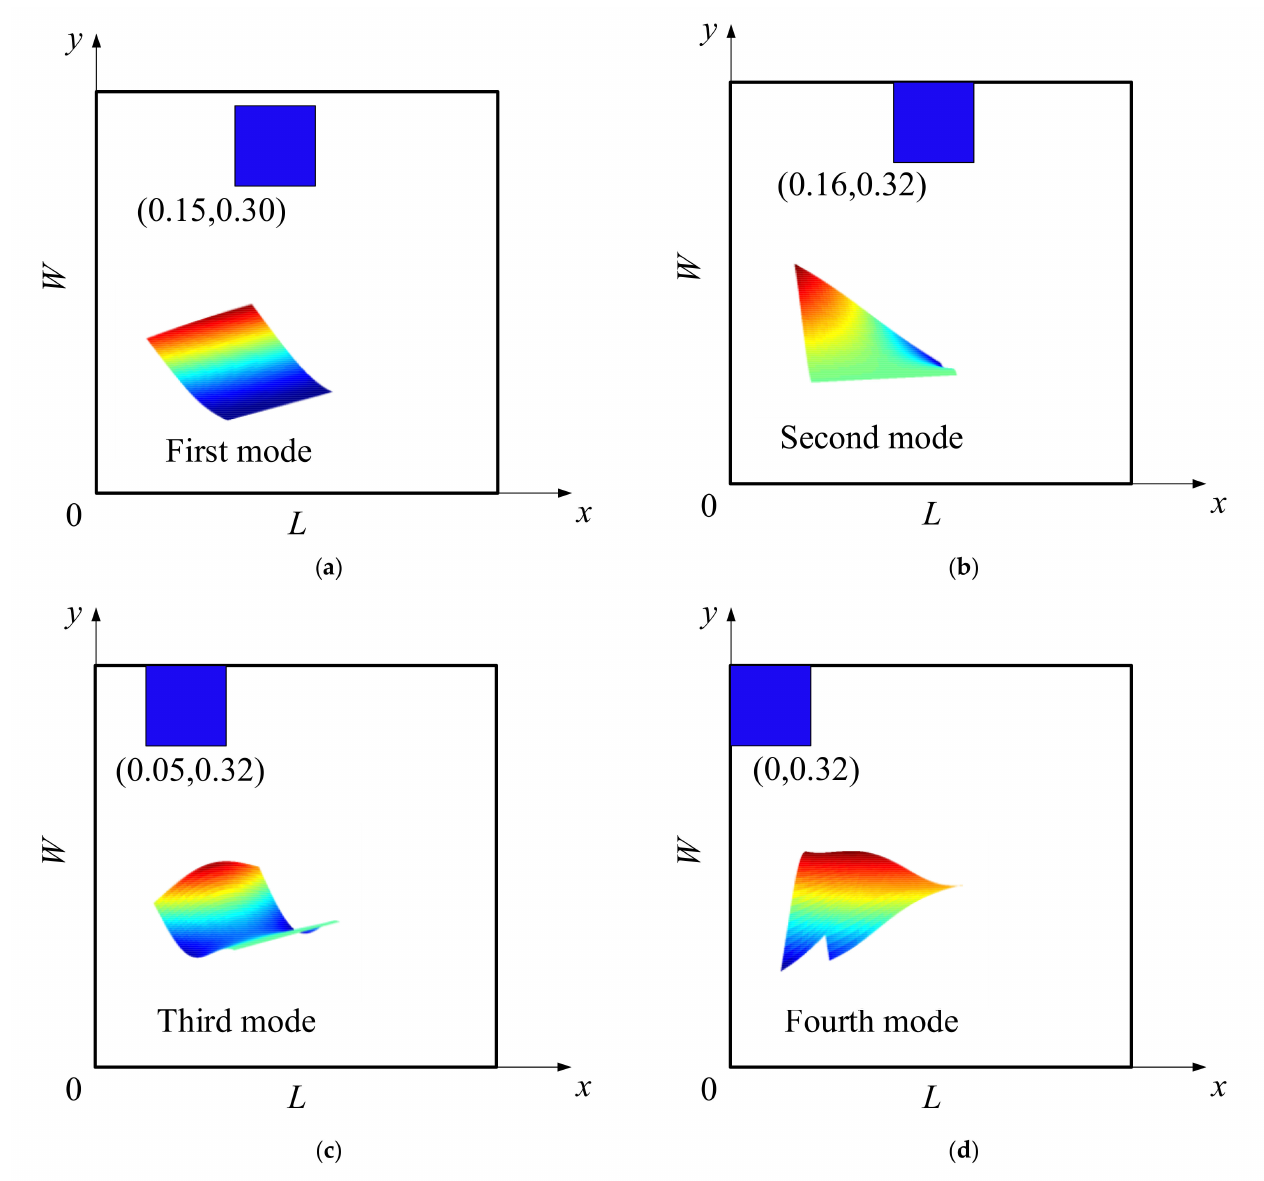
Figure 6. Optimal location of the patch for CFFF. ( a ) optimization for first order loss factor; ( b ) optimization for second order loss factor; ( c ) optimization for third order loss factor; ( d ) optimization for fourth order loss factor. Table 6. The first four loss factors after optimizing the location of the patch for